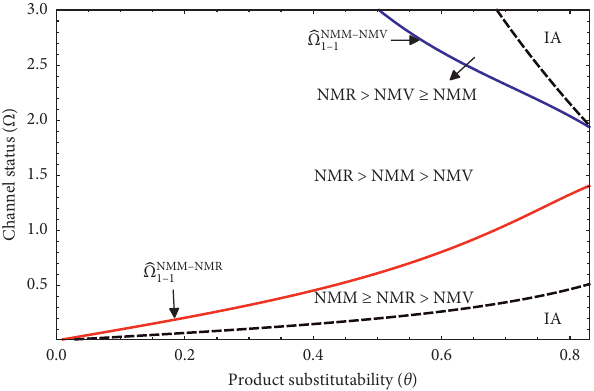
Figure 4: Comparison of channel 1 profits under MS.